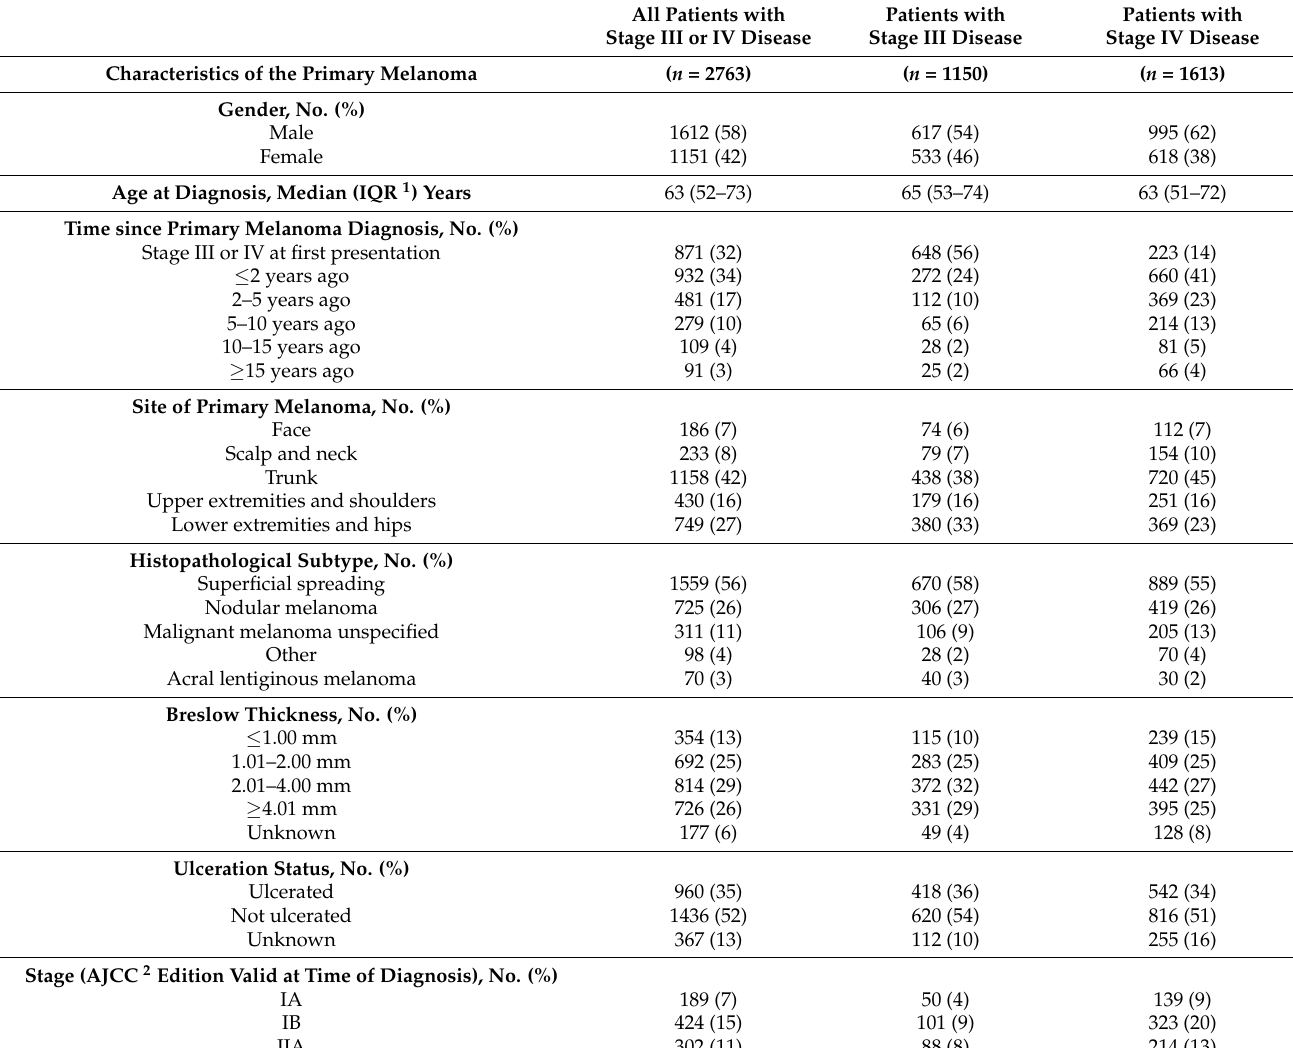
Table 1. Patient and tumour characteristics of the primary melanoma of patients with stage III or IV disease.